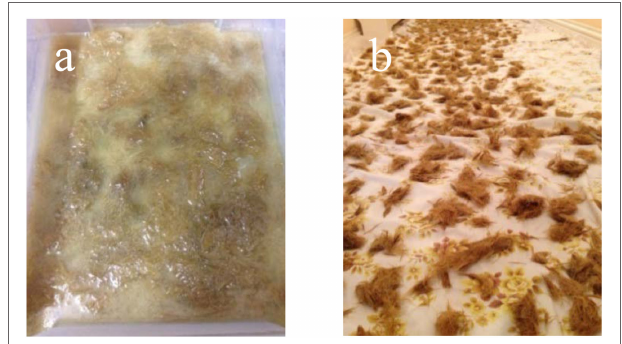
FIGURE 2 | Hemp fibers (A) submerged in Ca(OH) 2 solution and (B) drying after Ca(OH) 2 solution